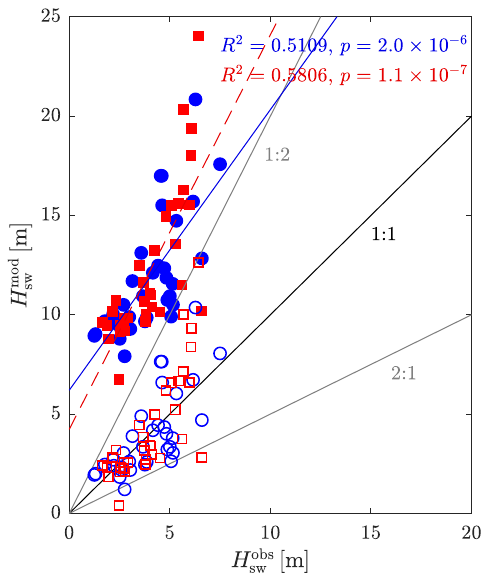
Figure 9. Modeled H mod sw versus observed H obs sw sand wave heights, for the calibration locations (filled blue circles) and validation locations (filled red squares). The R 2 and p values are the correlation values between H obs sw and H mod sw . Open symbols indicate rescaled sand wave height H res sw , using the obtained correlation for the calibration locations only (solid blue line). Finally, the dashed red line shows the correlation for the validation locations